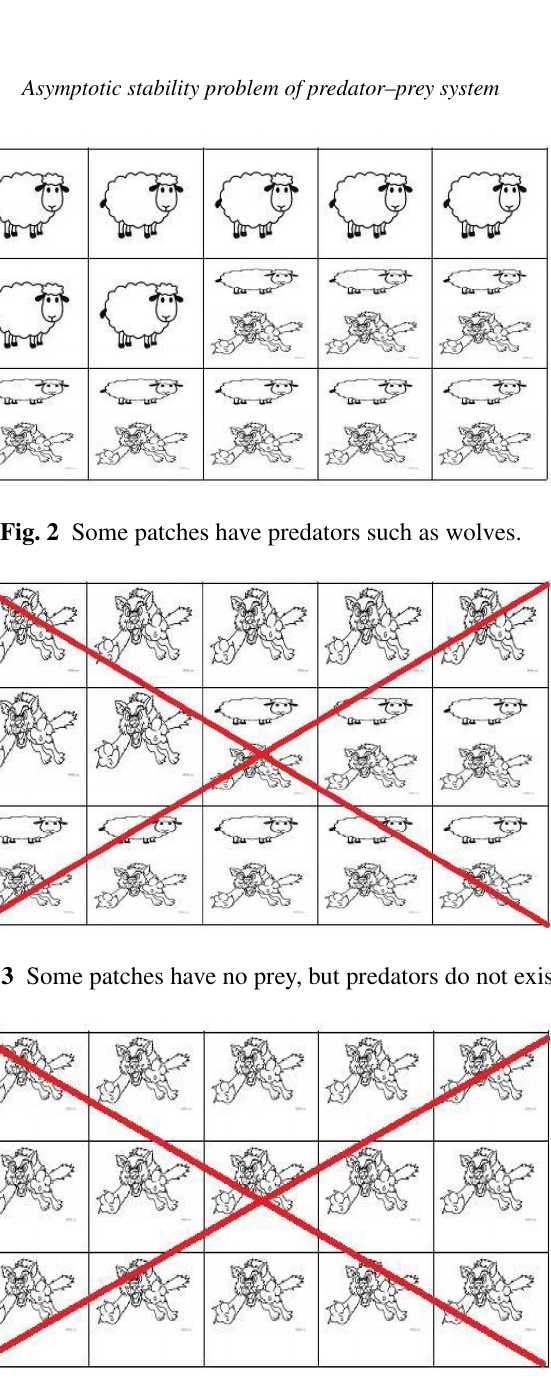
Fig. 4 State of all patches: they have no prey, but predators do not